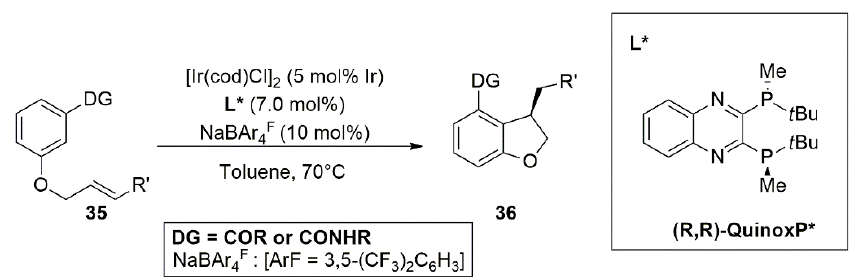
Figure 20. Synthesis of dihydrobenzofurans ( 36 ) by enantioselective intramolecular hydroarylation of aryloxyolefins ( 35 ).